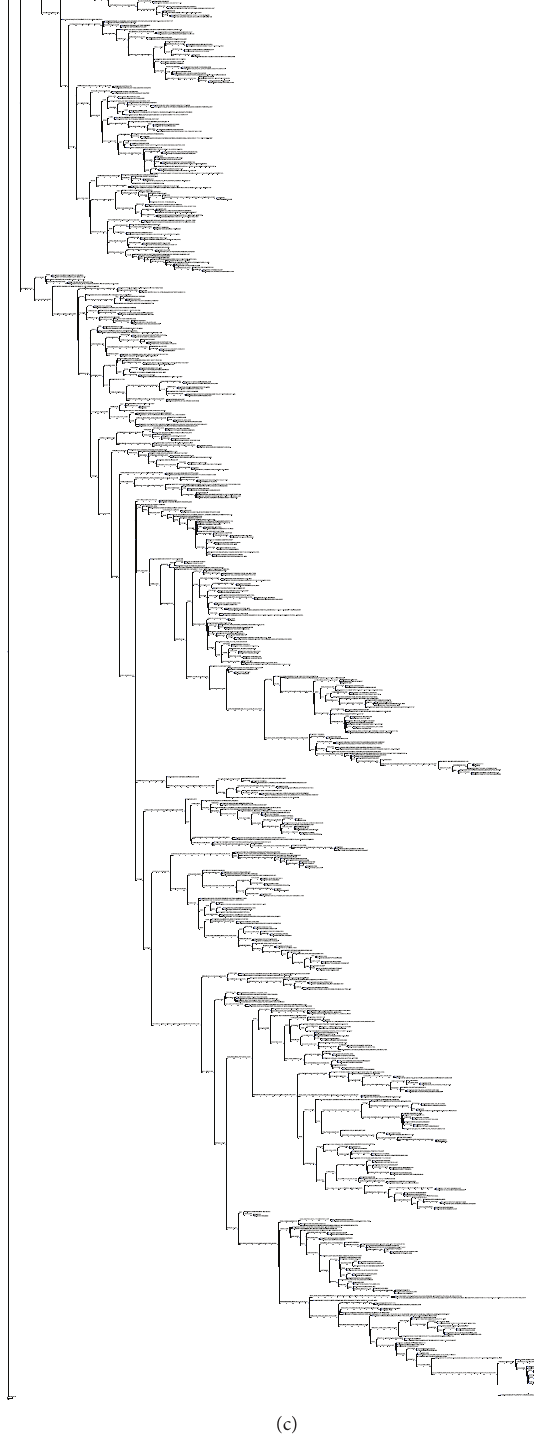
Figure 3: Phylogenetic trees for case studies discussed in this paper. (a) VH4-34 lineage in the human tonsil (84 sequences); (b) heavy chain clonal family from a 2-week-old zebrafish (43 sequences); (c) developmental lineage of the HIV bnAb CAP256-VRC26 over 8 timepoints (692 sequences). Larger copies of these trees, plus other output from AnnotateTree, can be found in the Supplementary